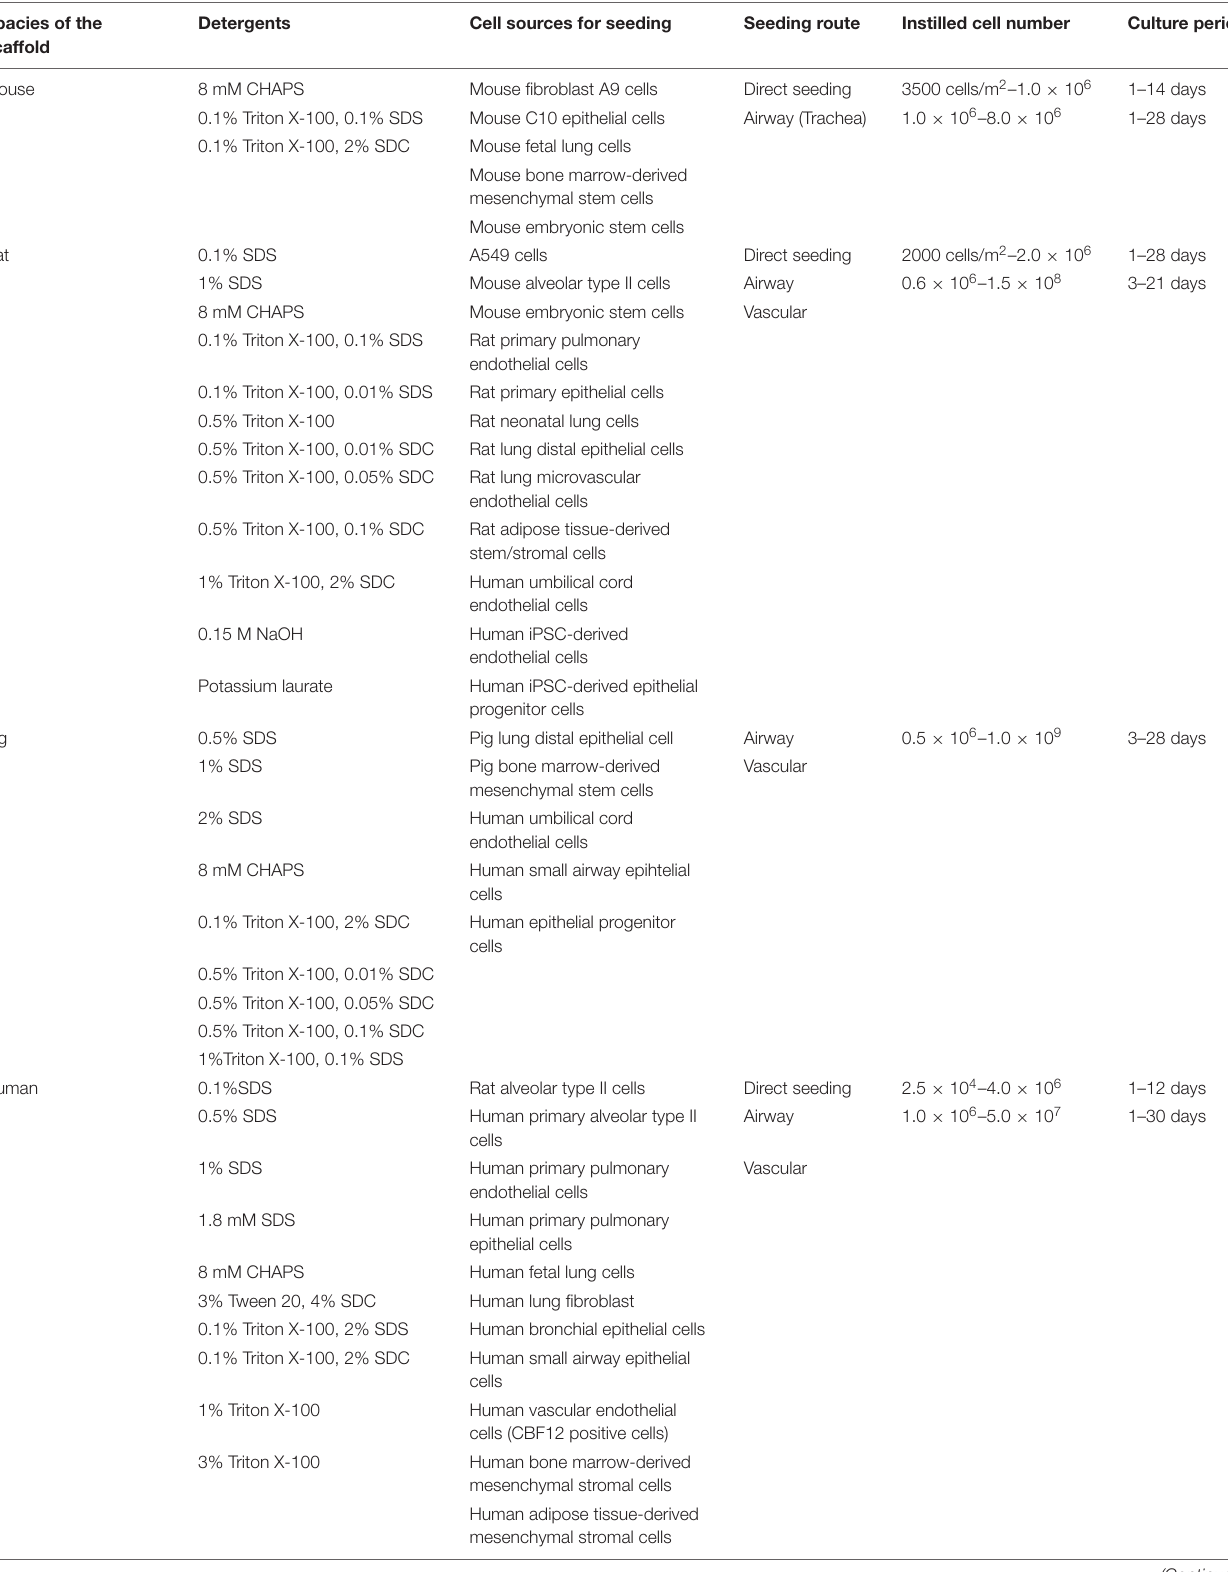
TABLE 1 | Summary of organ engineering using decellularized lung scaffolds. Spacies of the